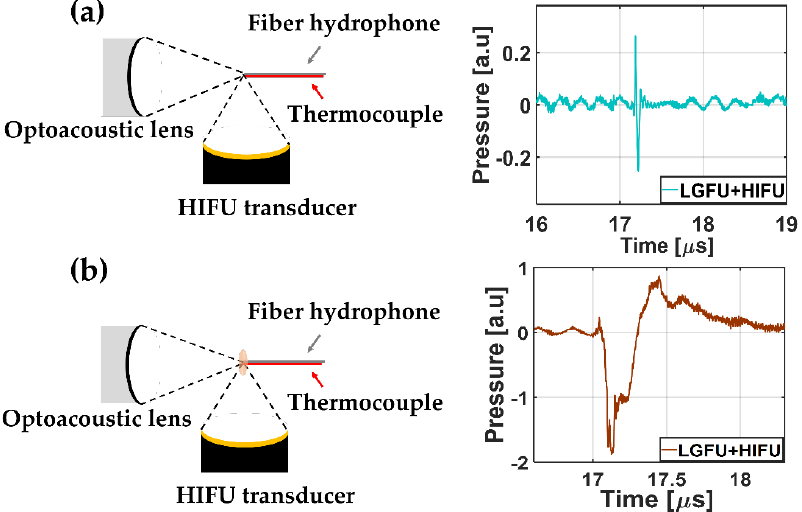
Figure 6. Combined waveforms of the LGFU and the HIFU are shown with negligible temperature enhancement in ( a ) (less than a few °C) and 9 °C enhancement in ( b ). While peak amplitudes of the LGFU and the HIFU were fixed for both figures, the duty cycle of the HIFU transducer was applied differently. For both operations in ( a , b ), temporal waveforms were recorded using the fiber-optic hydrophone after the temperature measurement.